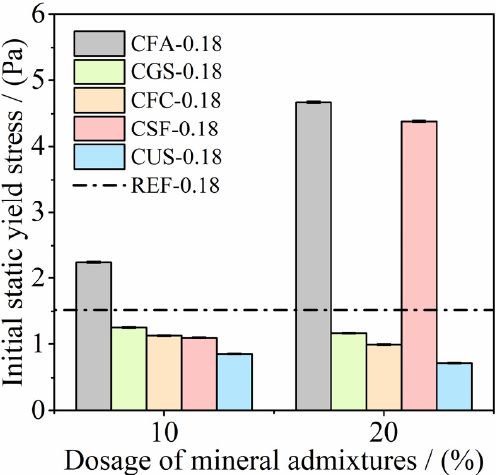
Figure 9. The change of the shear stress of UHPC-based pastes with time at the initial stage: ( a ) containing 10% of mineral admixture, ( b ) containing 20% of mineral admixture.